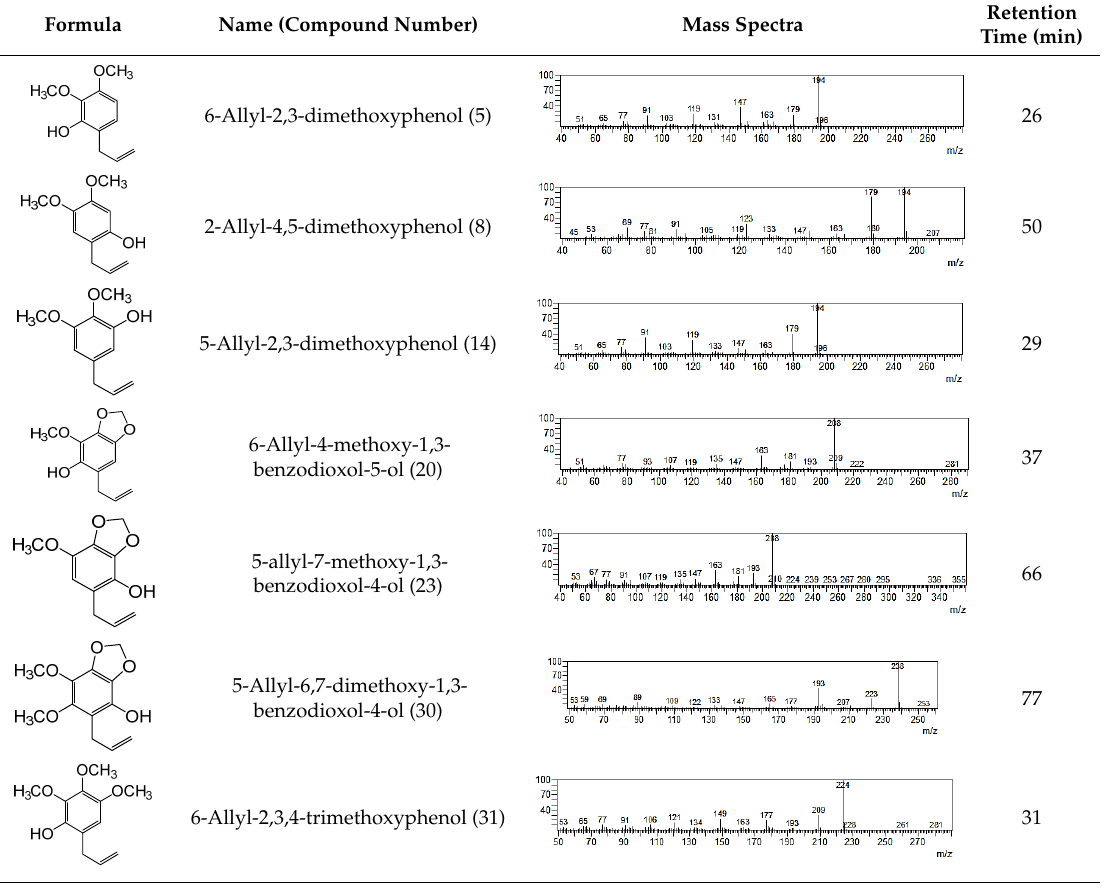
Figure 5. The reduced carbon monoxide (CO)-difference spectrum of the microsomal fraction of yeast harboring the Pf-49487 expression plasmid.